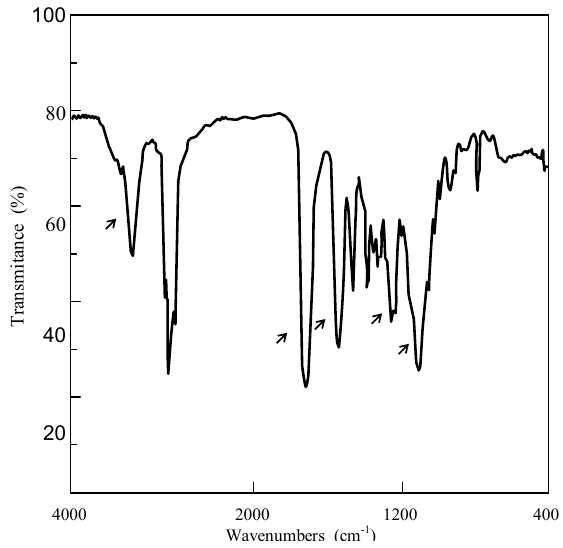
Figure 1. FTIR spectrum of polyurethane prepolymer synthesized with P 1 ( ¯M n PPG = 1300 g/mol) and NCO/OH = 2.3.